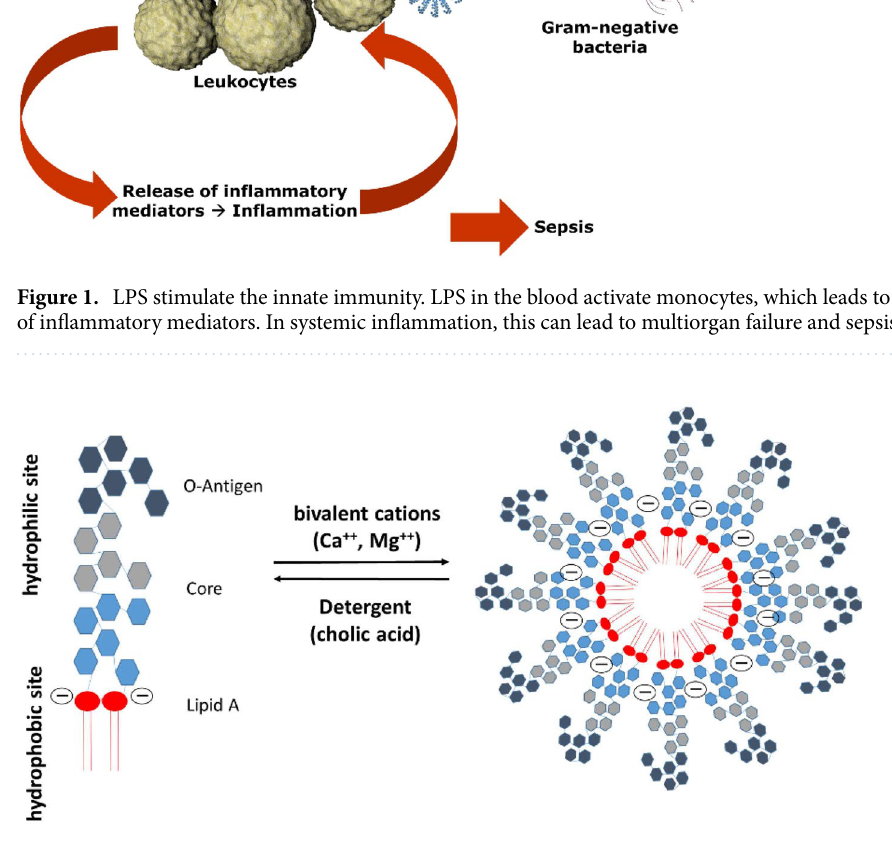
Figure 2. Structure of LPS aggregates. In aqueous solution monomecric LPS molecules form aggregates in the form of micelles or vesicles. Bivalent cations form bridges between the negatively charged phosphate groups in the lipid A fraction. By adding chelators (EDTA, citrate) and detergents (DOC, Tween, …), the LPS aggregates can be destabilized and disintegrate into monomers. In contrast to LPS aggregates, LPS monomers are no longer active both in the LAL cascade and immunologically (monocyte activation) 14,15